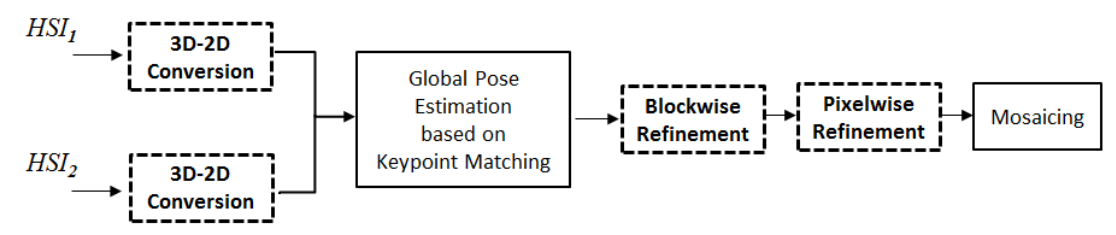
Figure 2. General scheme of the proposed hyperspectral image registration system where the dashed blocks correspond to the parts concentrated on in the proposed methods.